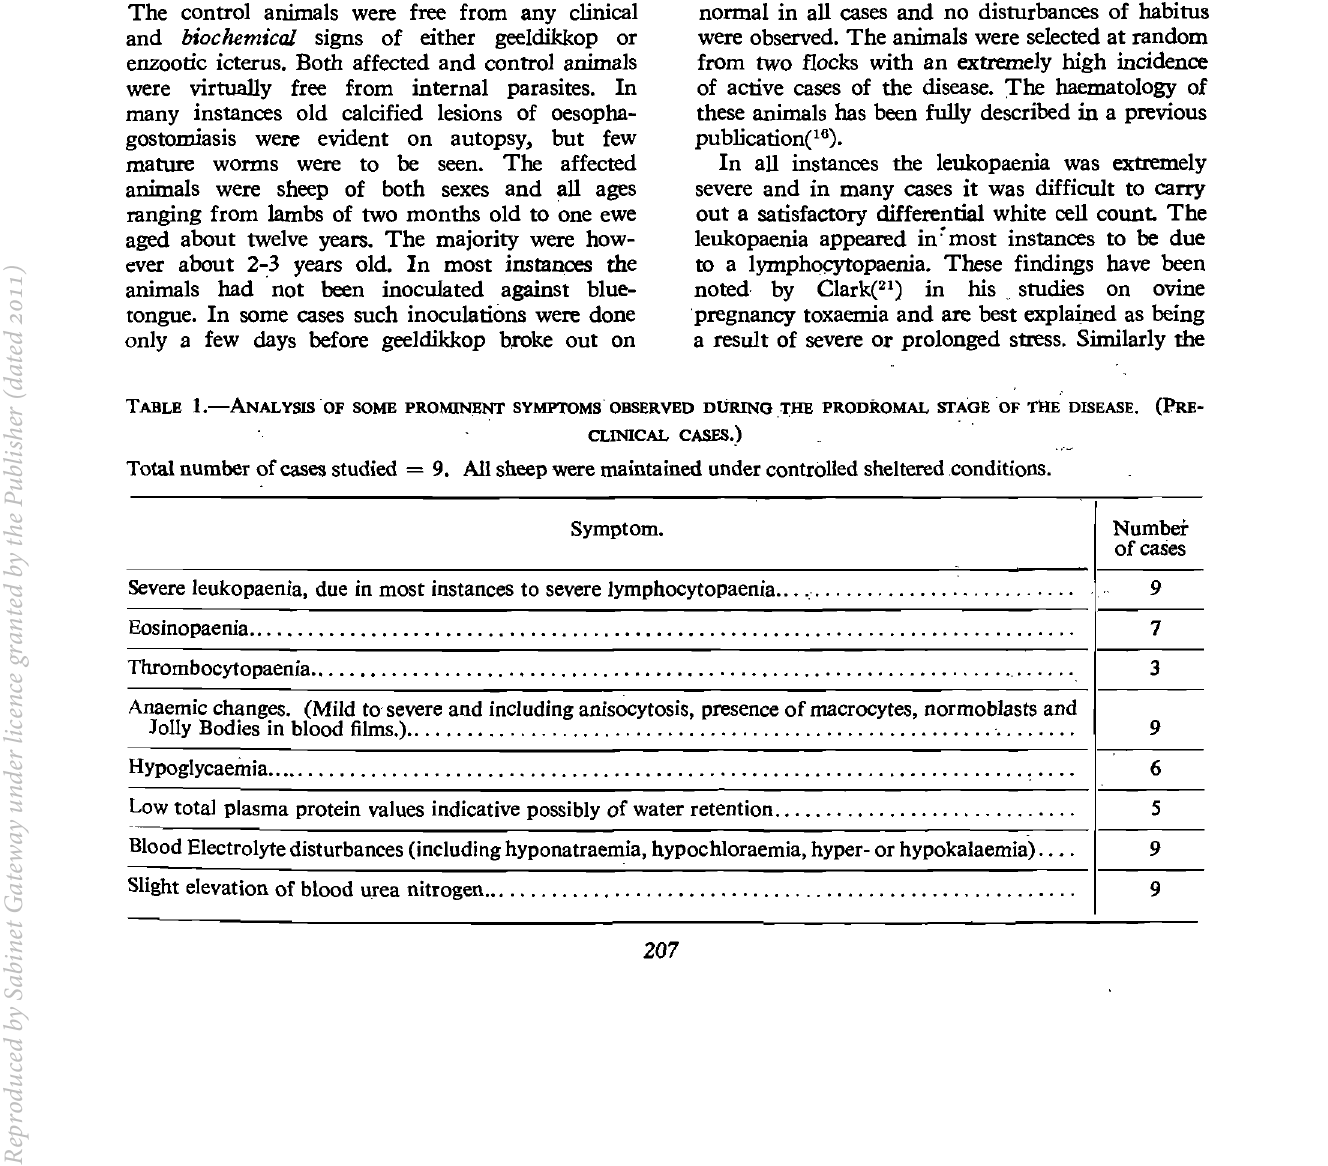
TABLE l.-ANALYSISOF SOME PROMINENT SYMPTOMS OBSERVED DURING .THE PRODROMAL STAGE OF THE' DISEASE. (PRE CLINICAL